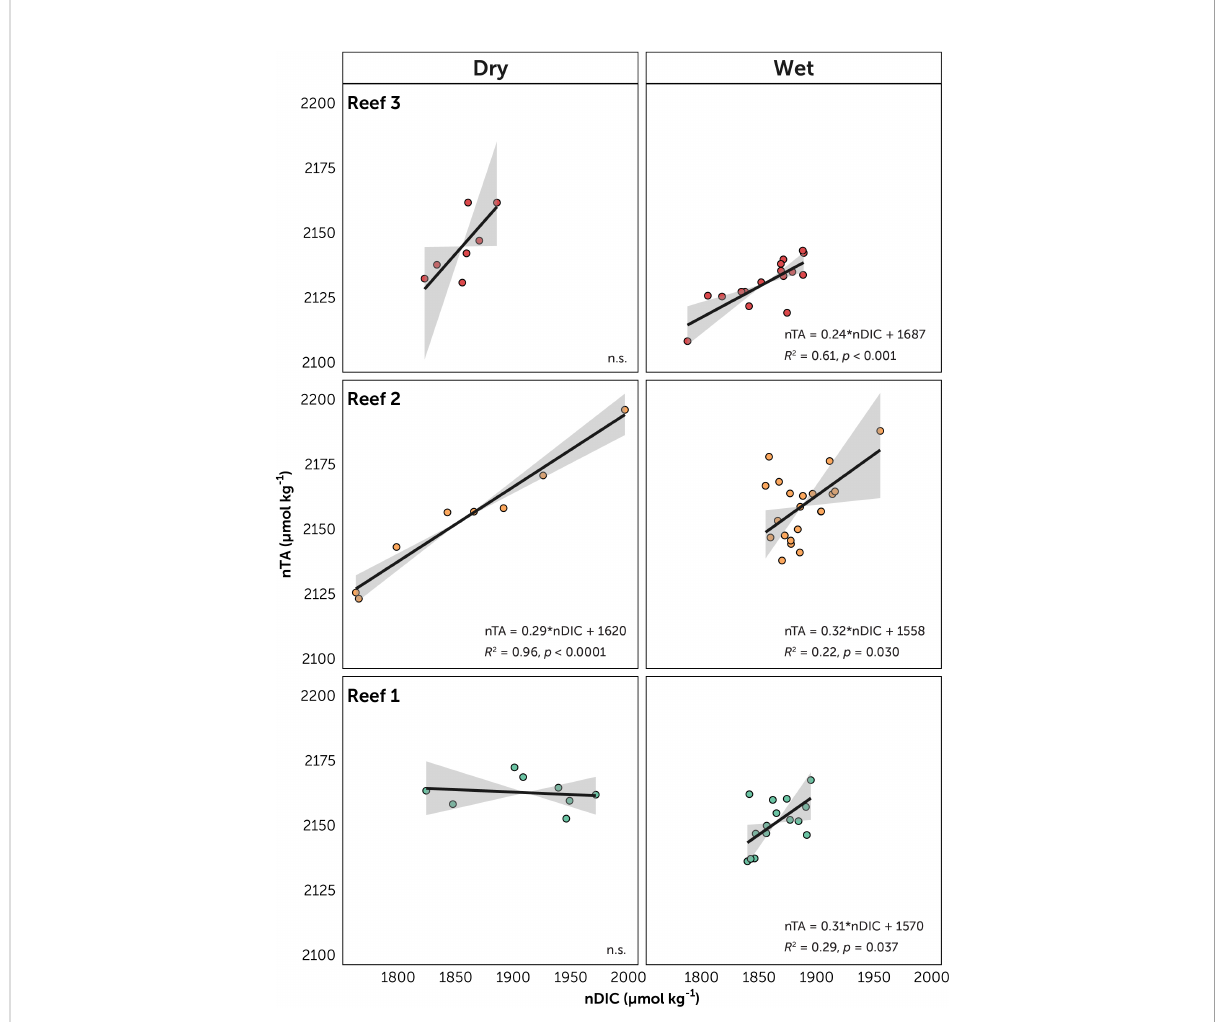
FIGURE 5 Relationships between salinity-normalized dissolved inorganic carbon (nDIC) and salinity-normalized total alkalinity (nTA) for the three reef stations, facetted by season. The solid line represents linear regression models (Model II, major axis method) with 95% con fi dence interval (gray area). Equation of the line, R 2 and p -values are given. Non-signi fi cant ( p >0.05) are marked